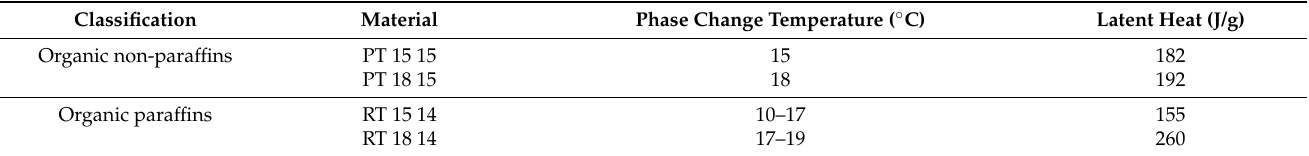
Table 1. Thermal properties of PCM candidates as provided by